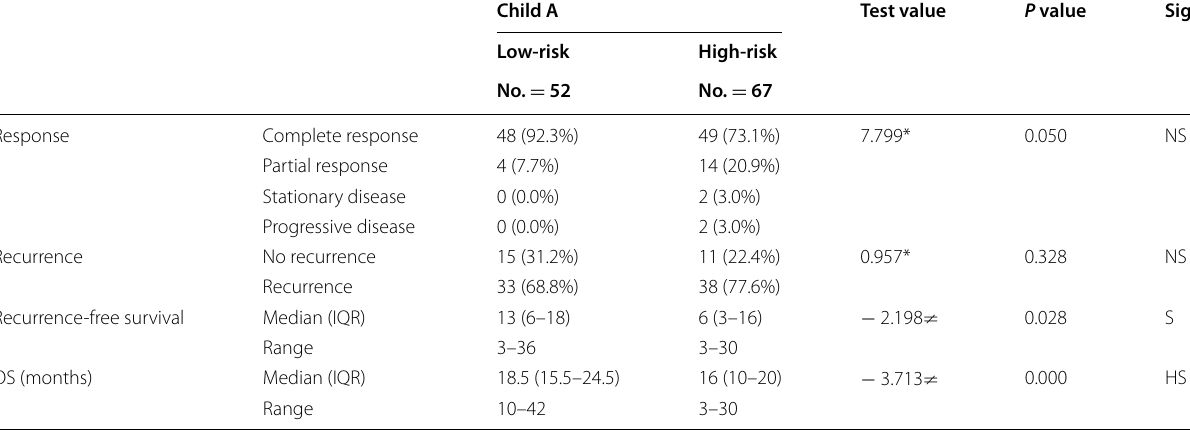
Table 7 Classifying Child A cases into low- and high-risk groups for TACE according to the AFP